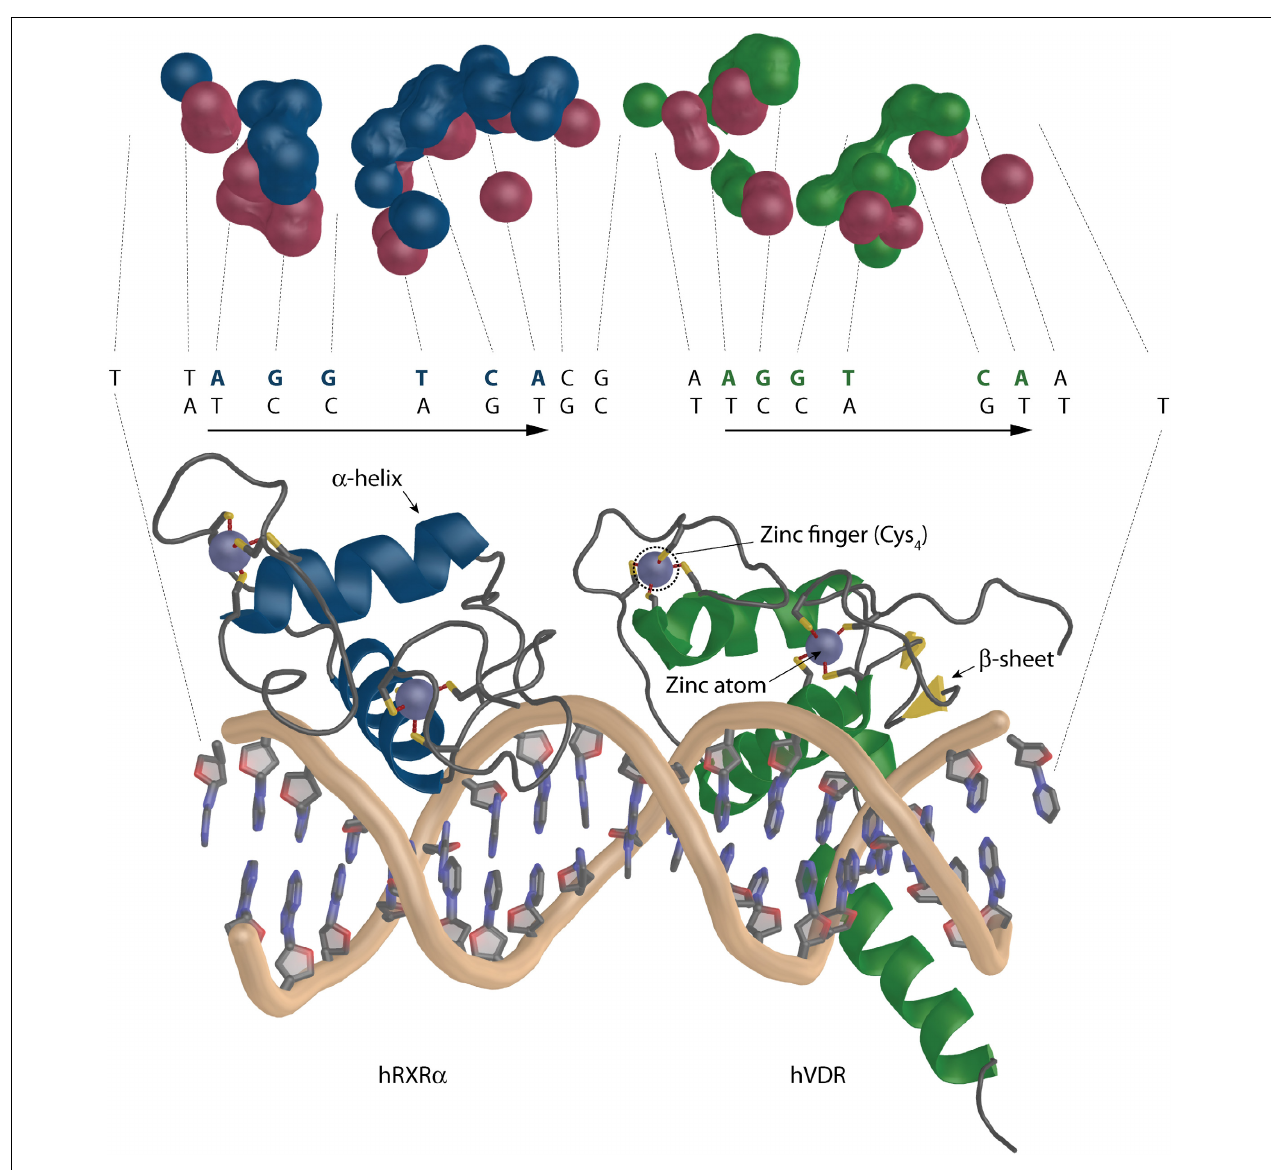
FIGURE 7 | The overall architecture of the DBD complex of RXR-VDR on canonical DR3 element (PDBID: 1YNW). The two zinc atoms (light blue spheres) with the respective cysteins are shown (bottom). RXR is shown in blue and VDR in green. The coiled protein regions are in